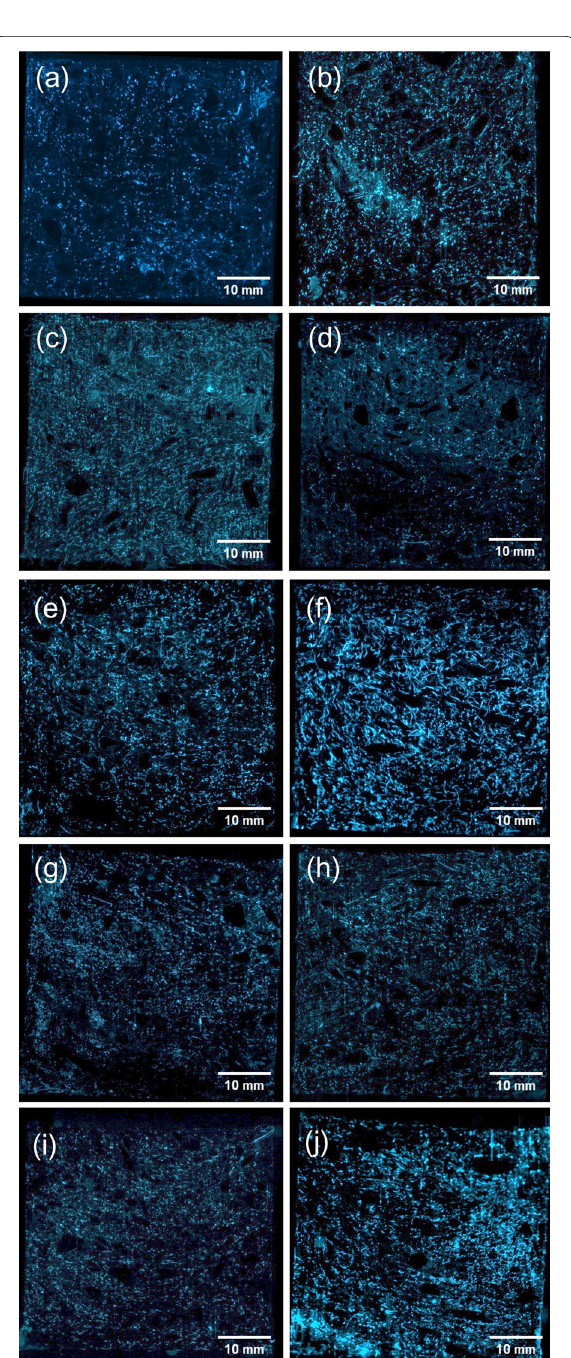
Fig. 19 Fluorescence images of natural fiber-reinforced concrete with kenaf fibers: a 5 mm, 0.5%; b 5 mm, 1.0%; c 5 mm, 2.0%;